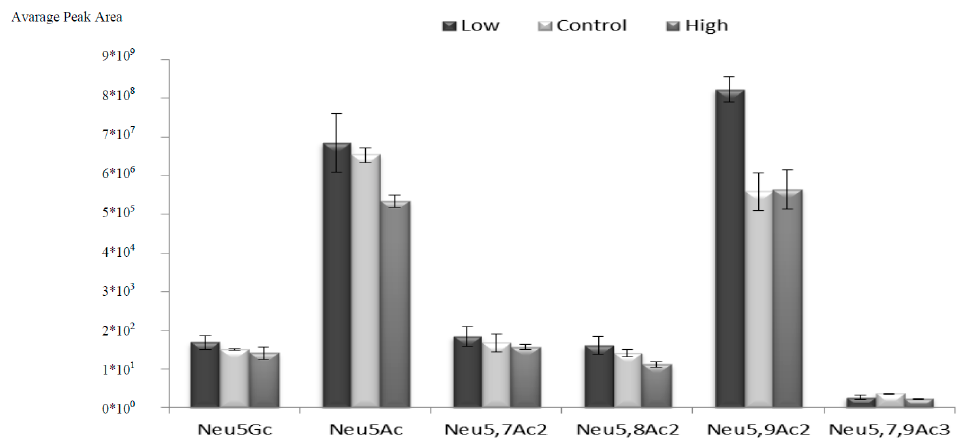
Figure 2. The distributions of total sialic acids in plasma.